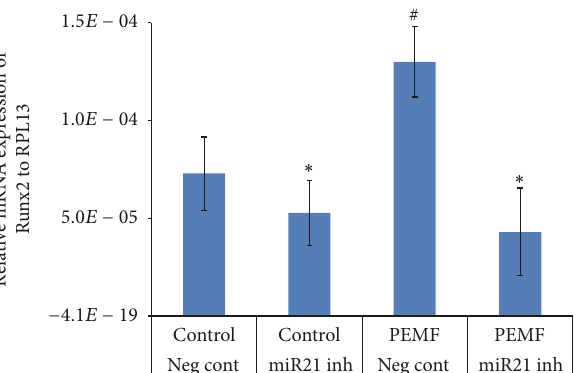
Figure 9: PEMF stimulated Runx2 expression and its effect was downregulated by miR21-5p inhibitor. Human BMSCs from a 27- year-old female were transiently transfected with 50nM of negative control miRNA or miR21-5p inhibitor for 3 days in osteogenic medium and PEMF treatment was carried out concurrently for 4 h each day for 3 days. Total RNA was isolated and RT-qPCR was carried out using the primers for Runx2. Expression of Runx2 mRNA is shown relative to that of the RPL13 gene. 𝑛 = 3 . ∗ indicates significant decrease compared to negative control miRNA transfection or PEMF treatment with negative control miRNA transfection. # indicates significant increase compared to control treatment with negative control miRNA transfection. Analysis by one-way ANOVA.